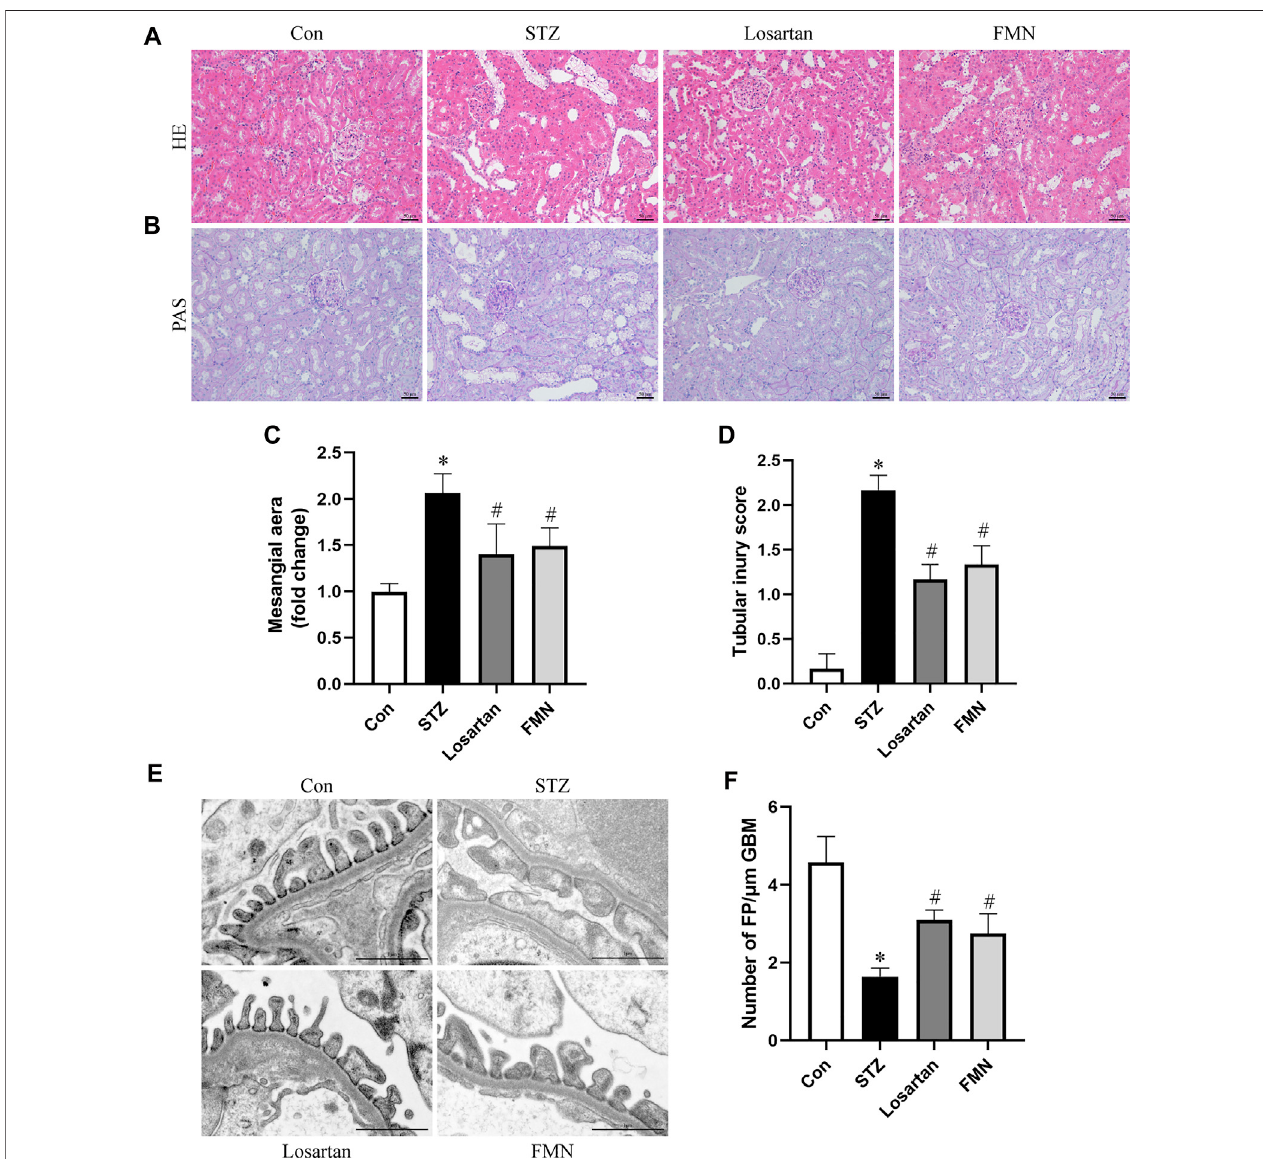
FIGURE2| FMNimprovedrenalhistopathologyandpodocytemorphologicalabnormalitiesindiabeticrats. (A,B) Renalhistologyevaluationswereperformedwith HE and PAS staining (original magni fi cation × 200, bars = 50 µm). (C,D) Semiquantitative analyses of mesangial area changes and tubular injury score. (E,F) Ultrastructure images of podocytes collected by transmission electron microscopy (TEM) (original magni fi cation × 8,000, bars = 1 µm) and semiquantitative analysis of podocyte FP density. Results were expressed as mean ± SD. * p < 0.05 vs. normal control rats. # p < 0.05 vs. STZ-induced diabetic rats.